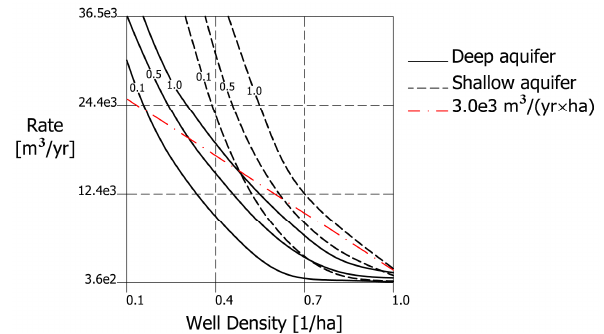
Figure 14: Diagram of Water Quality Index for Shallow and Deep Aquifer Fig. 14. Diagram of Water Quality Index for Shallow and Deep